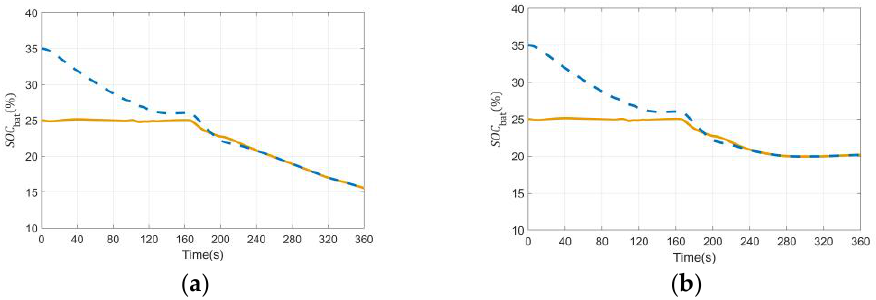
Figure 25. Variation in the SOC value of two lithium batteries under different strategies: ( a ) conven- tional vessel energy management strategy; ( b ) improved vessel energy management strategy.